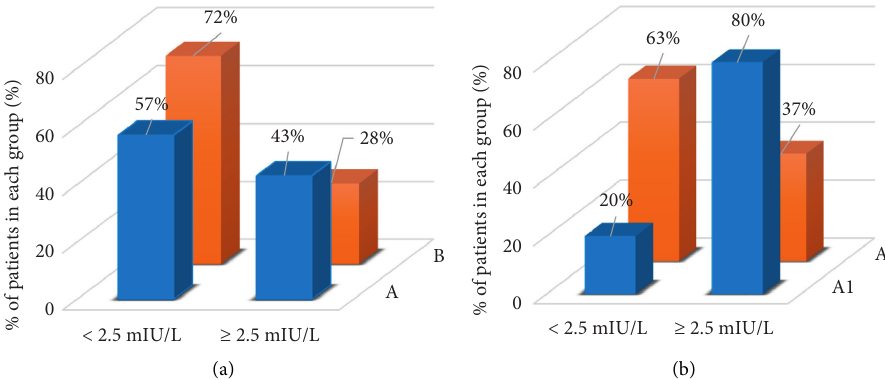
Figure 1: Percentage distribution of serum TSH values at T1 according to cut-off 2.5mIU/L in groups A and B (a) and in subgroups A1 and A2